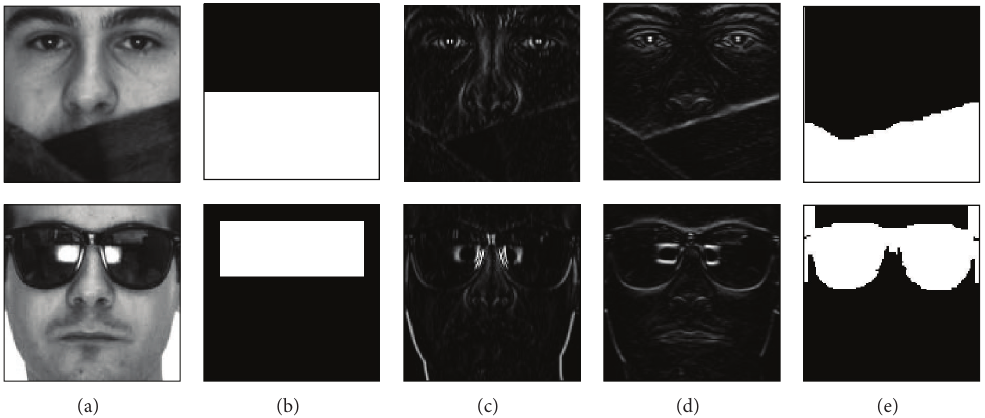
Figure4:Illustrationofourocclusionsegmentation:(a)examplesoffacesoccludedbyscarfandsunglasses;(b)initialguessoftheobservation set according to the results from our occlusion detector; ((c)(d)) the visualization of 𝑢(𝑖,𝑗) in horizontal and vertical directions, respectively; (e) the generated occlusion masks ( 𝜔 = 150